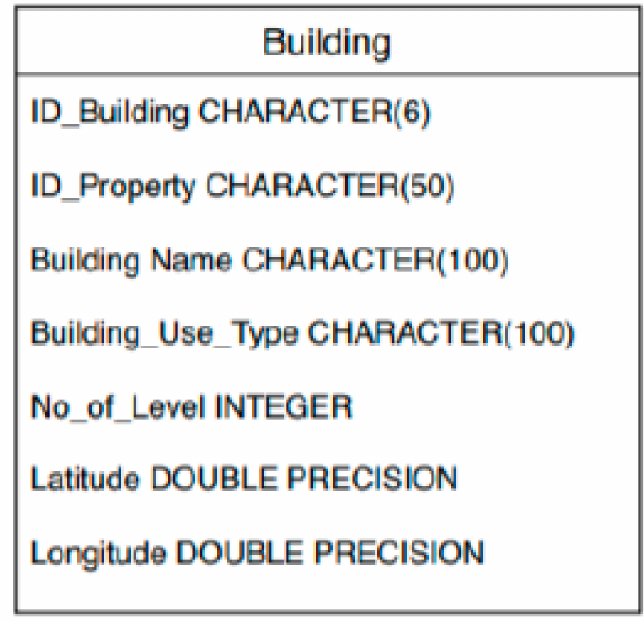
Figure 11. List of non-spatial attributes stored in a database.